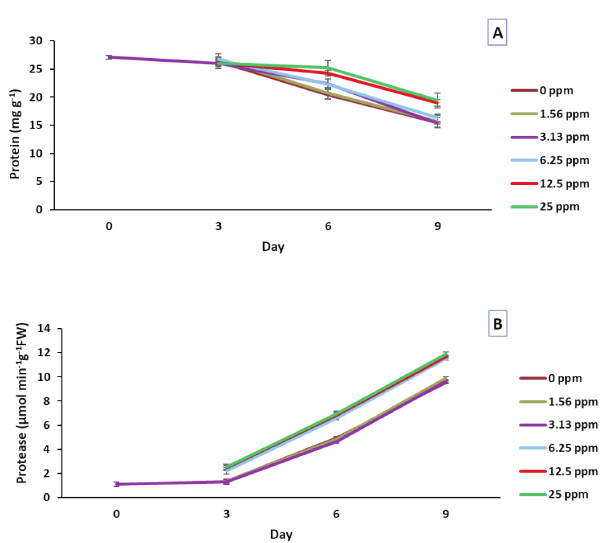
Fig. 3 ­ The influence of cumin EO concentrations on the protein content (A) and the activity of protease (B) under diffe­ rent observation periods in cold stored­radishes. Means ± SD of six replicates of two seasons are given (Tukey, p<0.01).